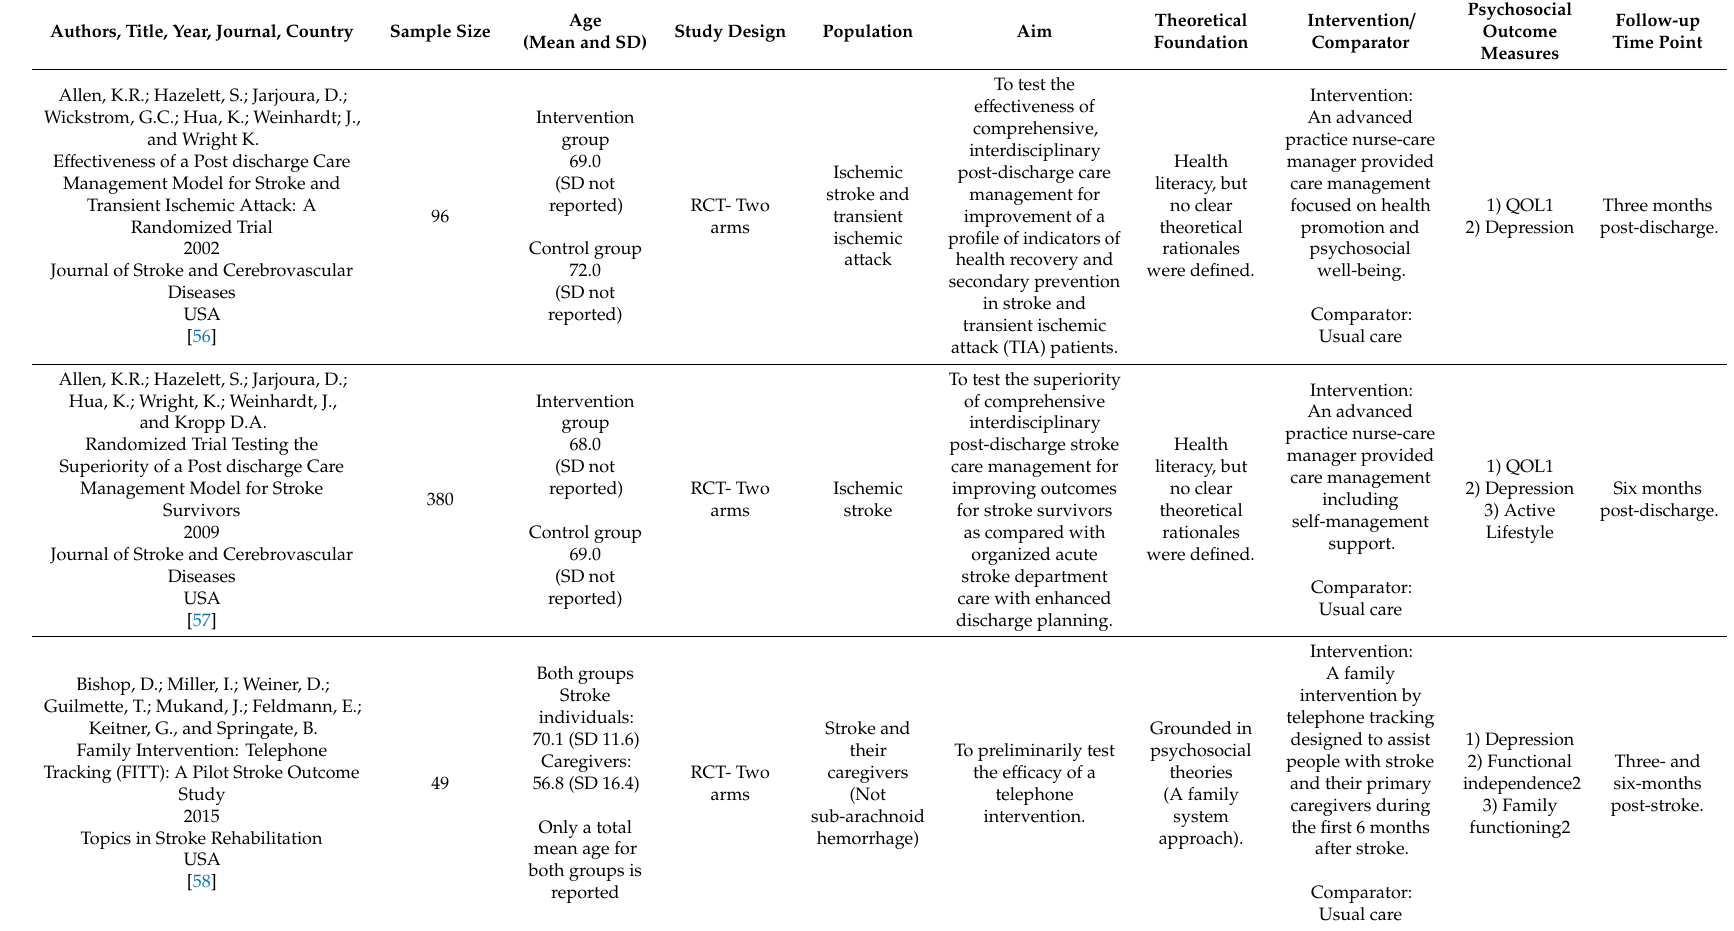
Table 2. Characteristics of included